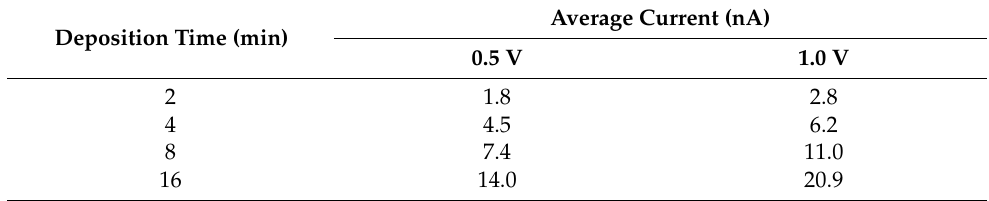
Table 1. Average currents of DNA-immobilized sensors with varied TiO 2 NPs deposition time. Deposition Time